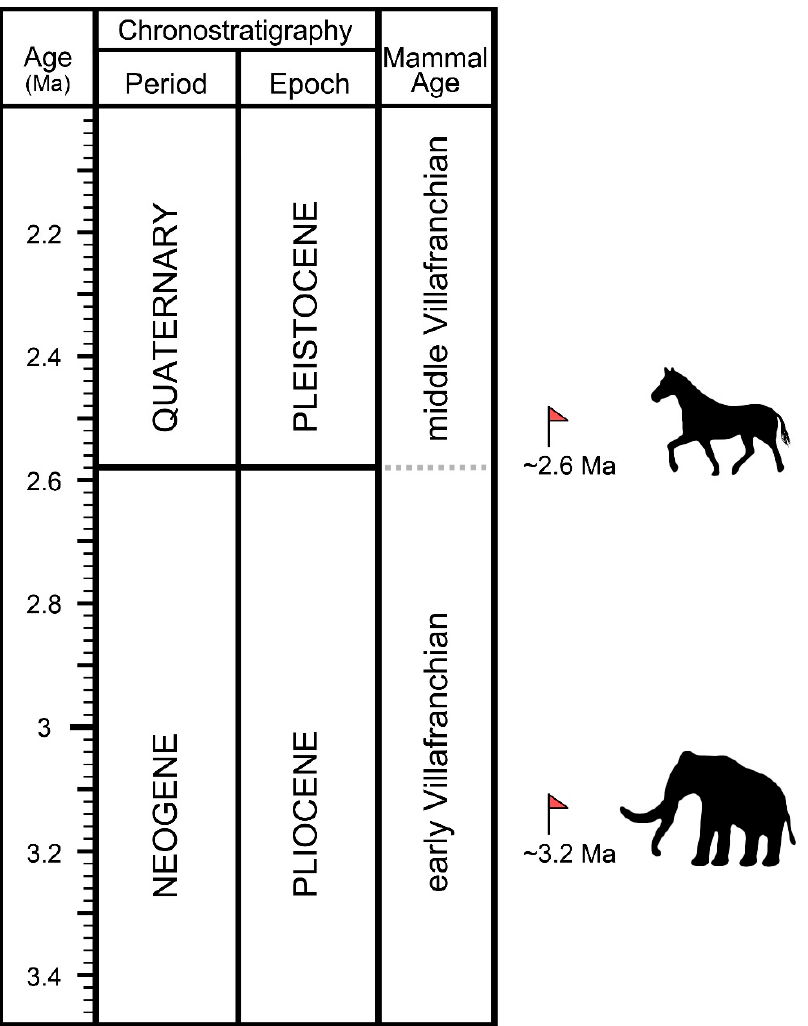
Figure 3. Chronological chart showing the first appearance of primitive elephantid ( Mammuthus ) and early monodactyl equid ( Equus ) in western Eurasia. In the region, the arrival of Mammuthus is an isolated bioevent calibrated at ~3.2 Ma, while the “ Equus event” testifies to a marked faunal renewal ~2.6 Ma.